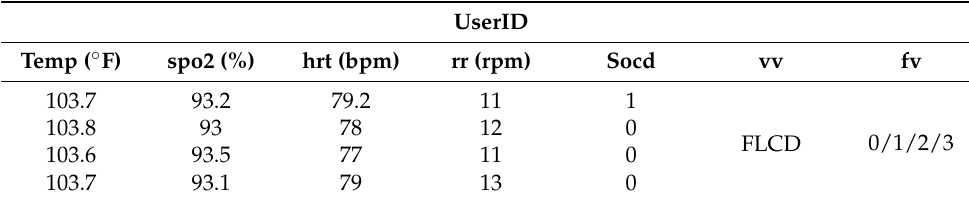
Table 3. Computed symptom data for understanding of FLCD system; temp ( ◦ F) = Temperature (Fahrenheit), spo2 (%) = Oxygen saturation (percentage), hrt (bpm) = Heart rate (beats per minute), rr (rpm) = Respiratory rate (respiration per